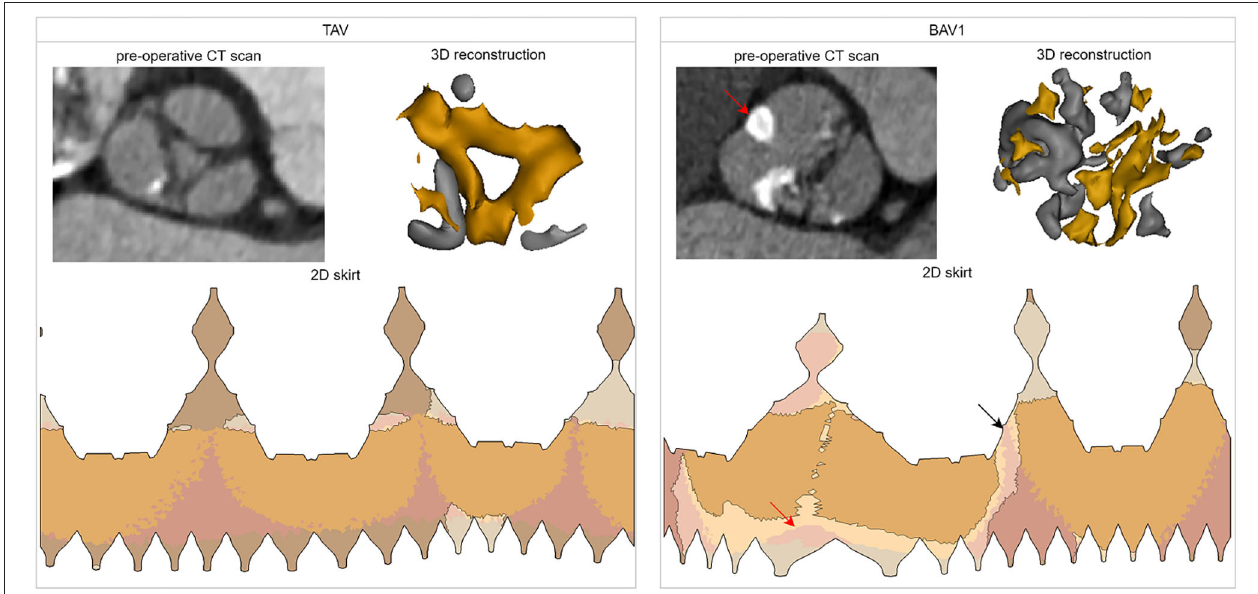
FIGURE 6 | Analysis of two cases of the cohort with different valve morphologies: TAV (total skirt malapposition of 4.4%, PVL grade 0) and BAV1 (total skirt malapposition of 20.9%, PVL grade 1). For each case, the following is shown: cross-section at the aortic annular plane in the pre-operative CT, three-dimensional reconstruction of the valve (and its calcifications), and distribution of the apposition/malapposition sections of the two-dimensional deformed device skirt. For the BAV1 case, the red arrow indicates the raphe and the black arrow the largest PVL channel. CT, computed tomography; 3D, three-dimensional; 2D, two-dimensional.